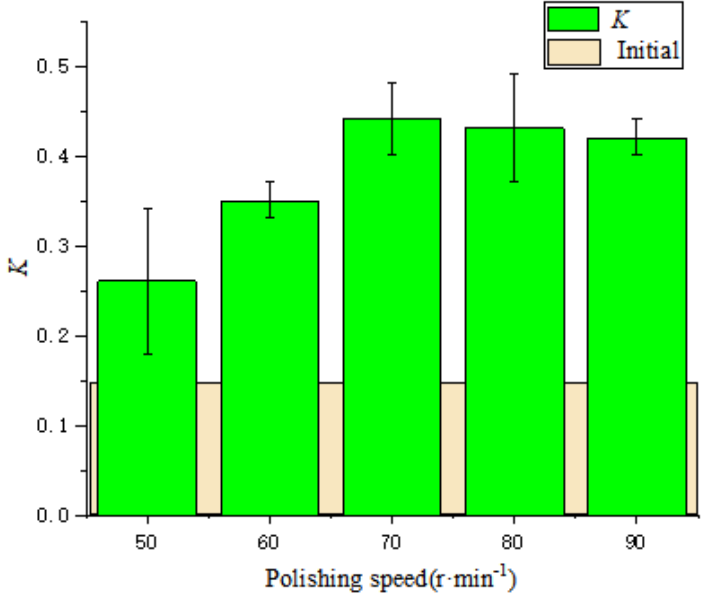
Figure 17. The change of the shape factor K with the polishing speed.